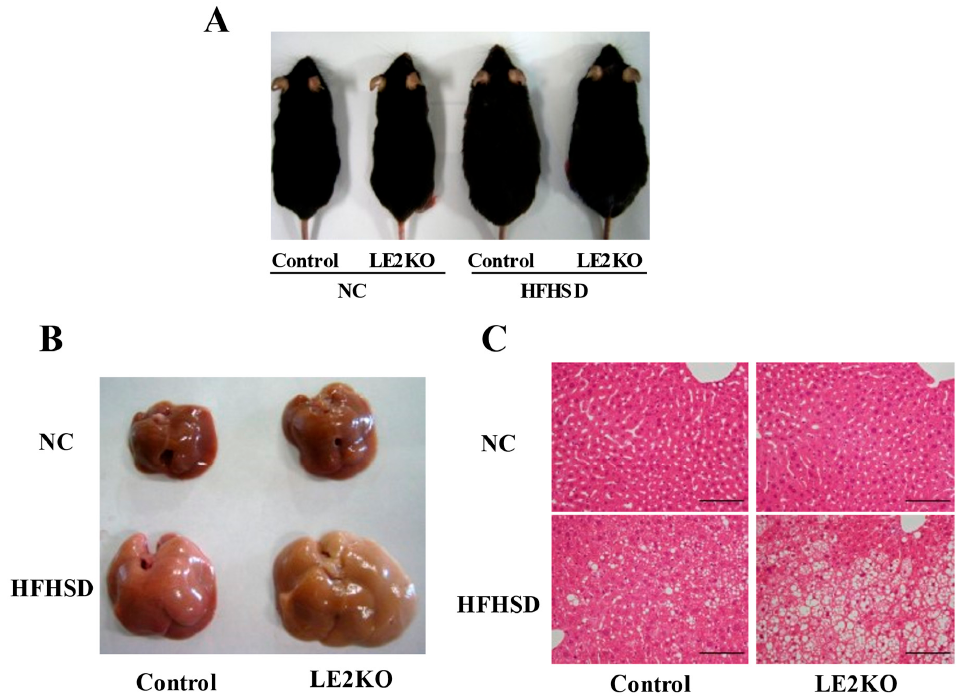
Figure 1. Typical body appearance and macroscopic or microscopic images of liver. LE2KO showed similar increases in body weight with HFHSD for 20 weeks ( A ) HFHSD-LE2KO significant increased liver weight ( B ) and fat deposition ( C ) compared with HFHSD-Control. 2.2. Decreased Phosphorylation of AMPK/ACC and the Increased Expression of SREBP-1c in Liver from HFHSD-LE2KO We employed the pathway analysis of gene chip and compared the gene expression of the liver from HFHSD-LE2KO and HFHSD-Control in the previous report [7,8] and the supplemental file. The enzymes for FA synthesis were up-regulated, and the enzyme for FA oxidation was down-regulated in HFHSD-LE2KO. AMP-activated protein kinase (AMPK) is the potent regulator for the balance of FA oxidation/synthesis. Immuno-blot- ting of hepatic homogenate showed the decreased phosphorylation of AMPK and acetyl- CoA carboxylase (ACC), a downstream enzyme of AMPK (Figure 2A–C). The expression of the sterol regulatory element-binding transcription factor 1c (SREBP-1c), which is the master gene for the transcription of FA synthesis, was markedly increased in HFHSD- LE2KO by reverse transcription-polymerase chain reaction (RT-PCR) (Figure 2D). We did not find the significant upregulation of genes for gluconeogenesis, such as glucose6-phos- phatase or phosphoenolpyruvate carboxykinase (data not shown).